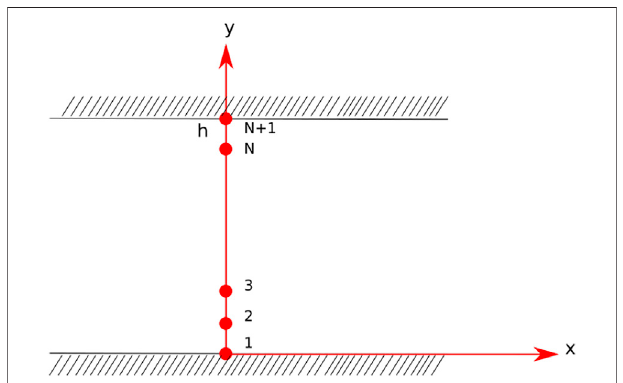
FIGURE 1 | 1D channel fl ow with N + 1 grid